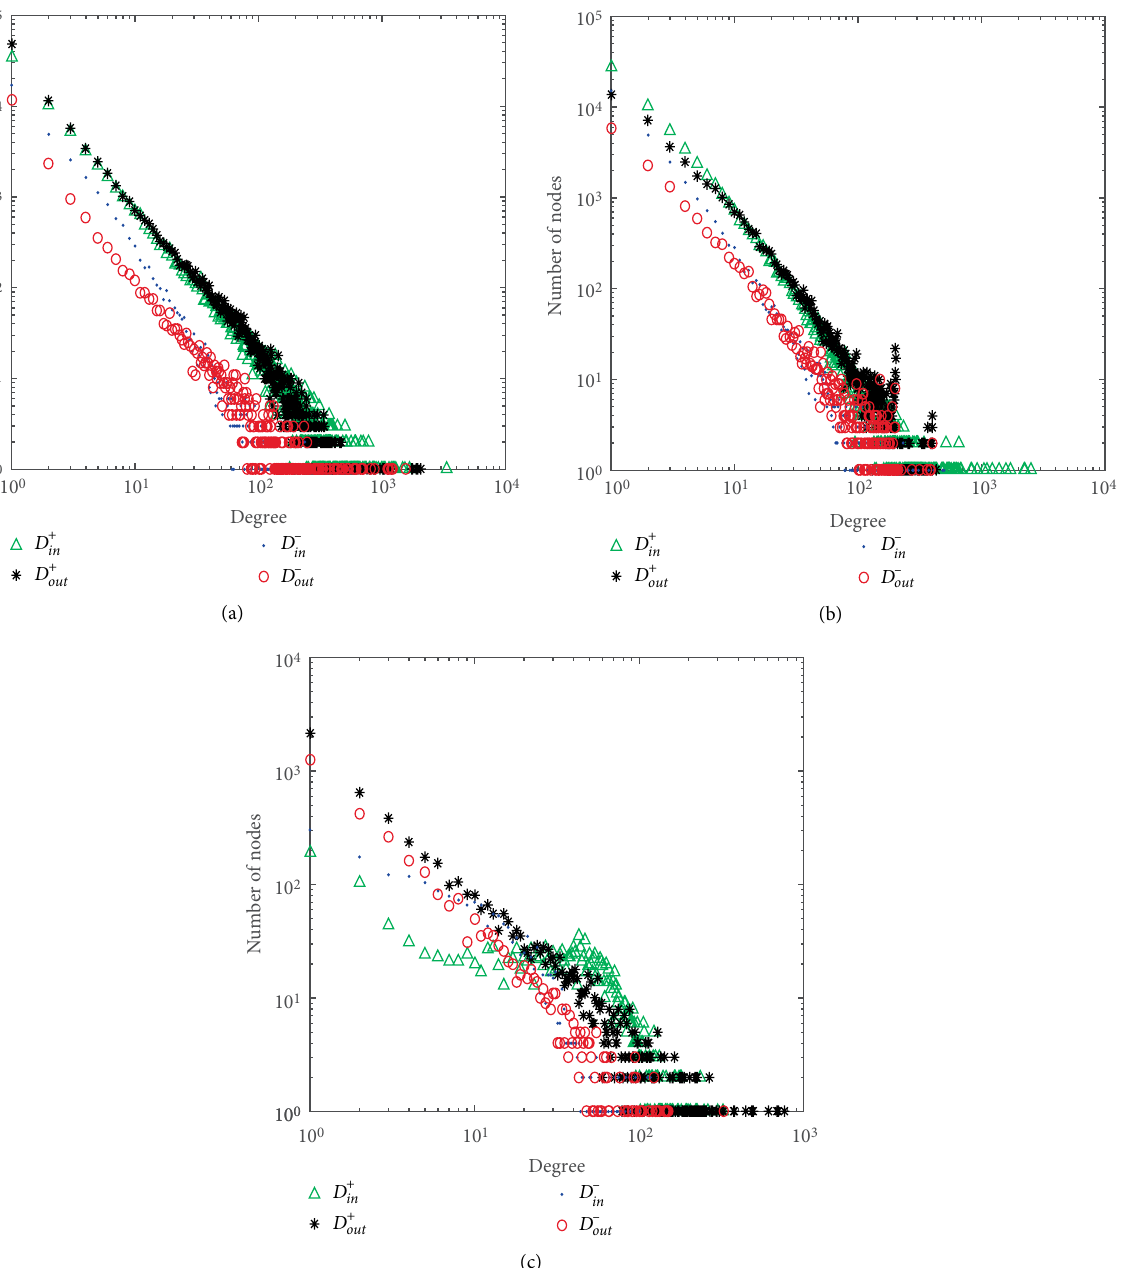
Figure 5: Degree distributions of the three real data sets. (a) Epinions. (b) Slashdot. (c)